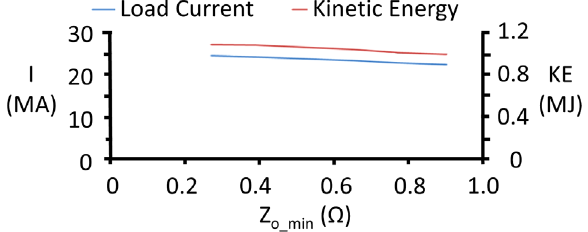
FIG. 3. The peak current in the load and the plasma kinetic energy at a convergence ratio of 10 are shown as a function of the minimum vacuum wave impedance in the CSMITL design.